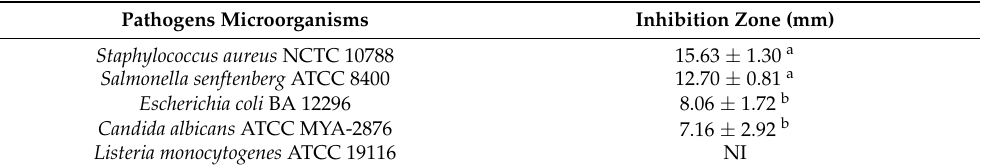
Table 3. In vitroantimicrobialactivityof Cleomedroserifolia (Forssk.) Del. againstpathogenicmicroorganisms.